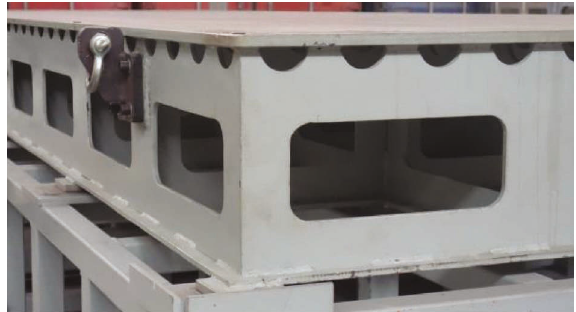
Figure 13: The forming tool is based on the results of the